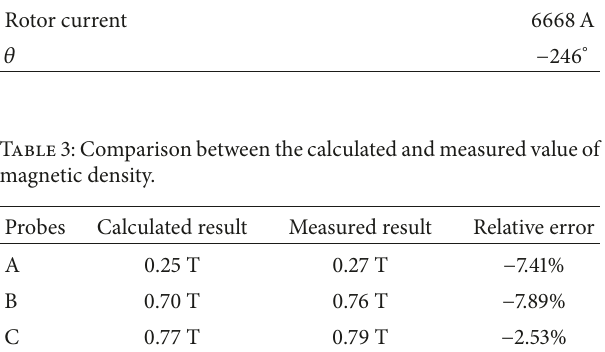
Figure 3: Solution domain of the 2D model.